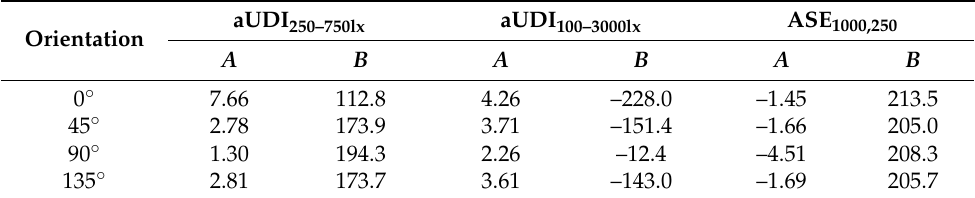
Table 8. The A and B coefficients of linear regression models between Y and each daylight metric at each